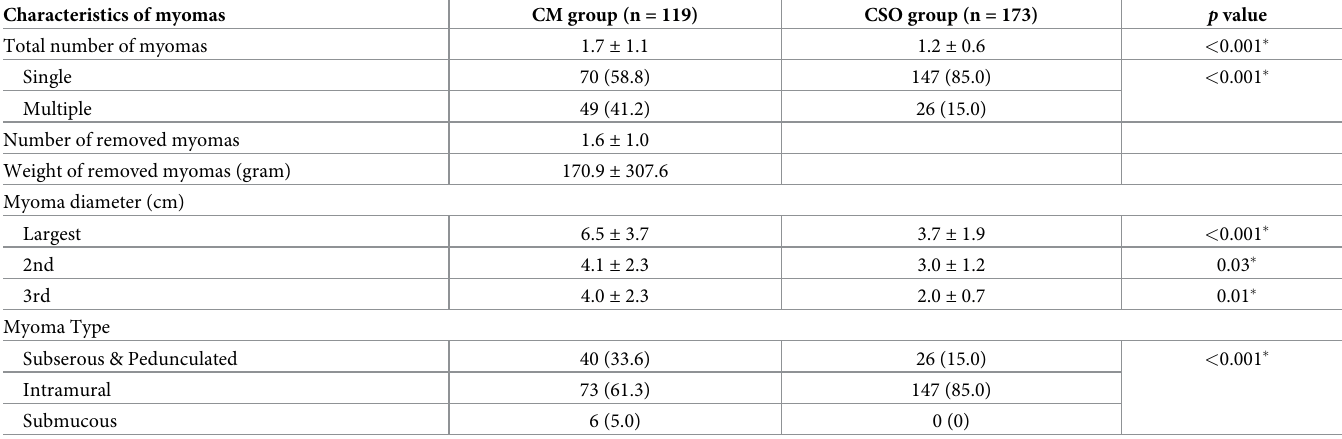
Table 2. Comparison of characteristics of myomas between CM group and CSO group (n = 292). Characteristics of myomas